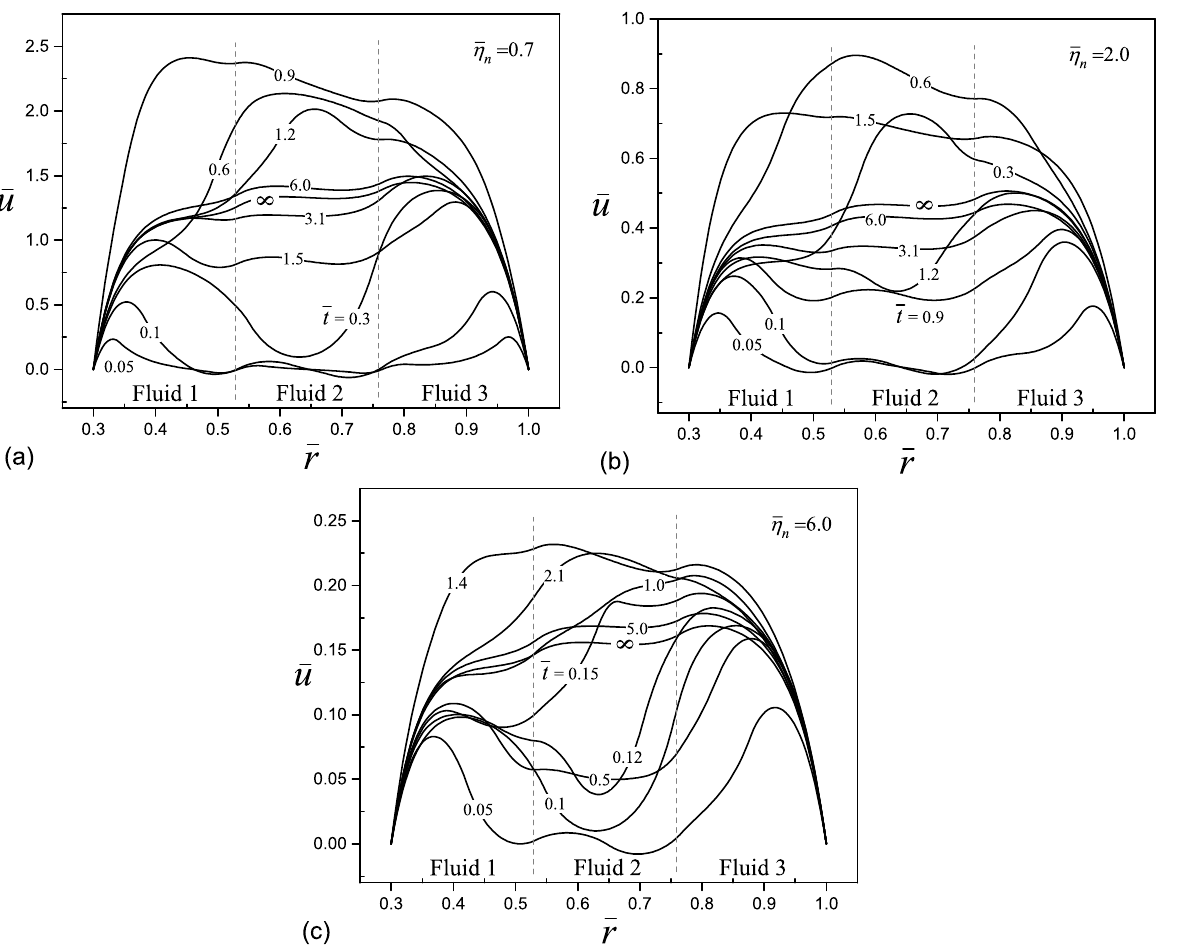
Figure 5. Dimensionless velocity profiles of an electro-osmotic flow with n = 3, a = 0.3, Γ = 0, ∆ ¯ ψ n = 0.25, ¯ κ n = 20, ¯ ρ n = ( b ) ¯ η n = 2.0, and ( c ) ¯ η n =